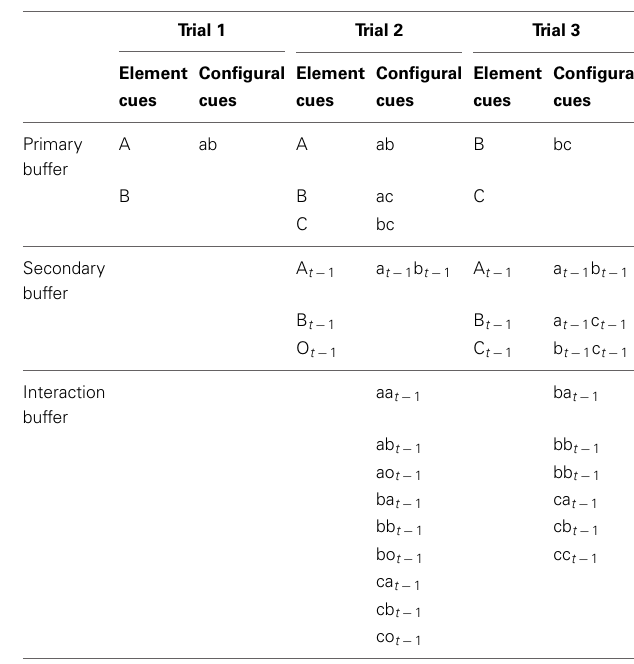
Table A1 | Parameters used, and optimization boundary values, in RWM and MECAM simulations.